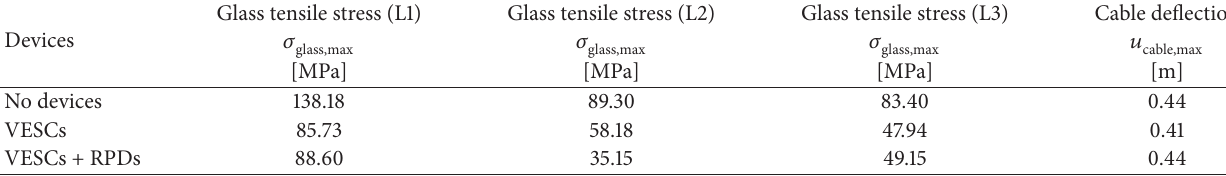
Table 2: Numerical results of dynamic analyses (ABAQUS). Level D-GSA.